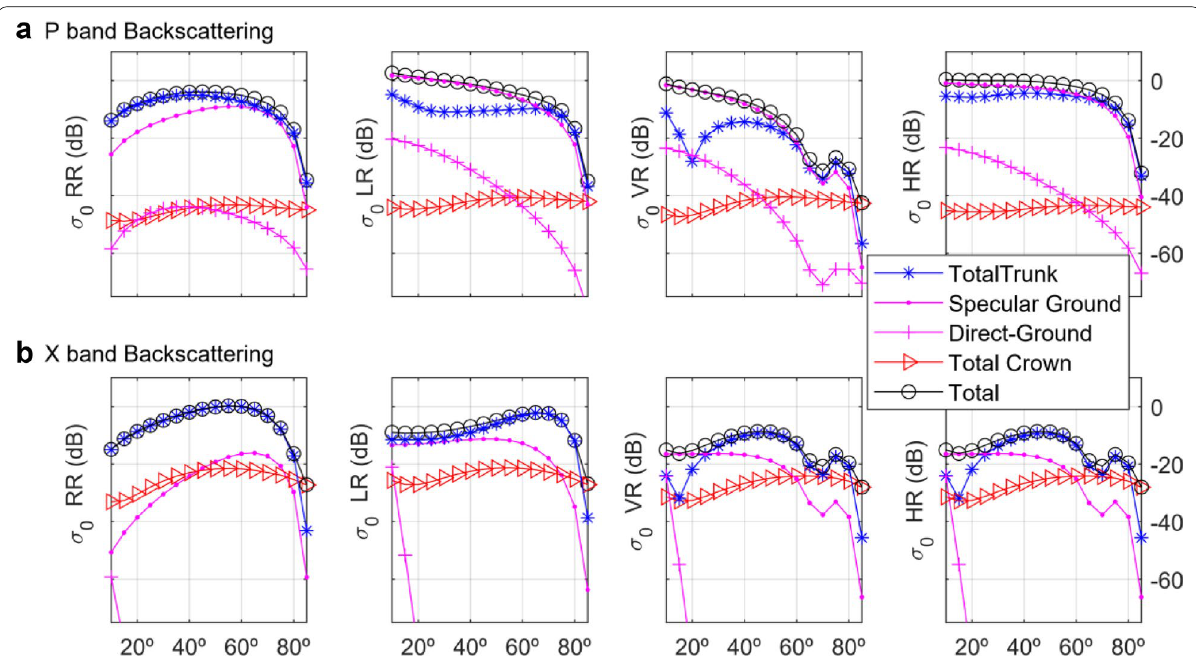
Fig. 5 a P and b X-band canopy scattering contributions versus scattering angle from aspen at the backscattering plane for various polarizations